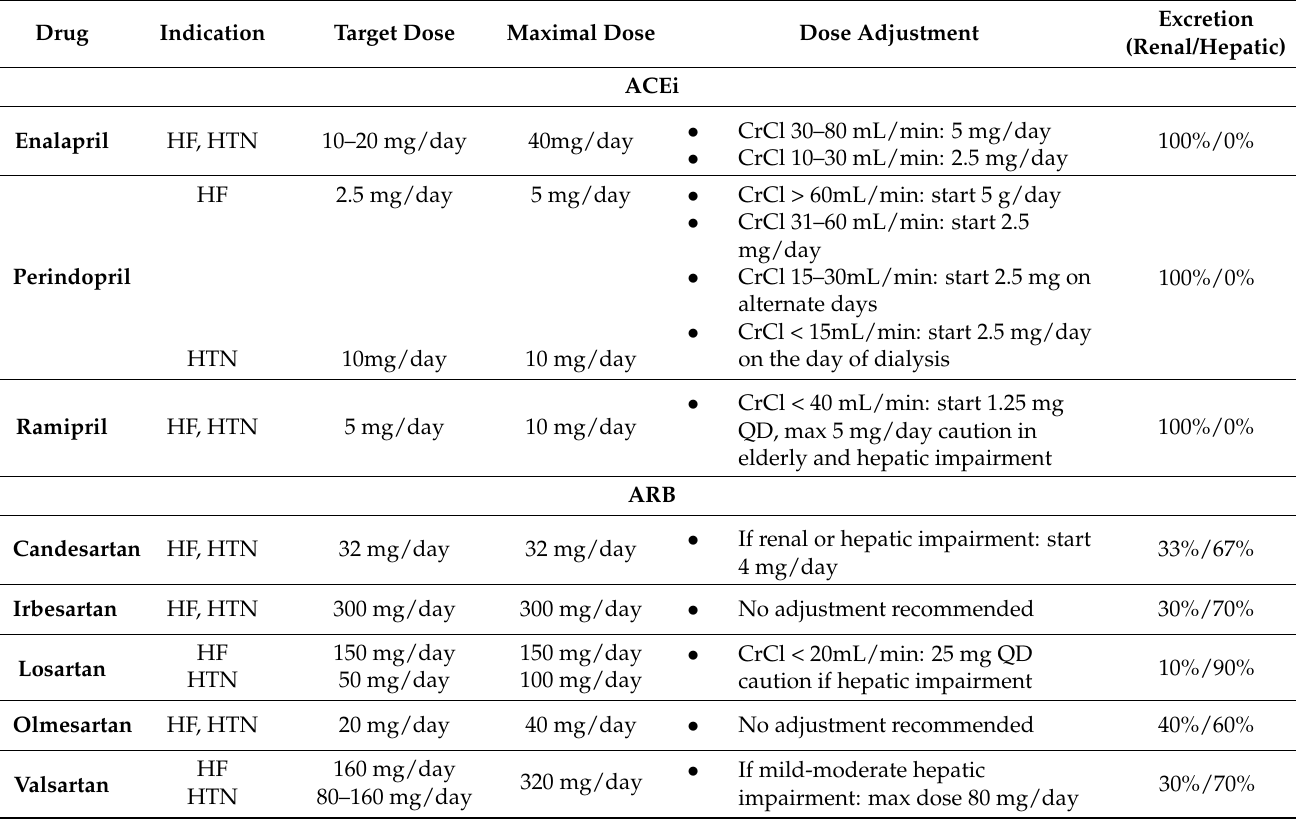
Table 1. Suggested dosage of ACEi and ARB and dose adjustment according to the GFR